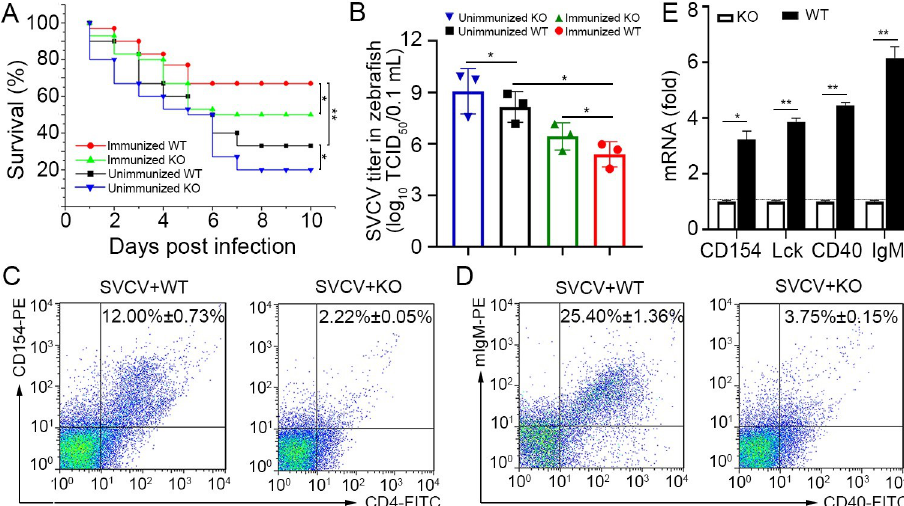
Fig 9. Verification of the functional role of Env38 in knockout zebrafish. (A) The functional role of Env38 was verified by the impairment of the antiviral activity of Env38 -/- zebrafish after vaccination with formaldehyde- inactivated SVCV vaccine or infection with live SVCV. In both wildtype and knockout zebrafish, the immunized groups were i.p. inoculated with vaccine derived from 0.4% formaldehyde-inactivated SVCV (10 6 TCID 50 ) and then challenged with SVCV (10 5 TCID 50 ); whereas the unimmunized groups were challenged with SVCV (10 5 TCID 50 ) without vaccination. Data points were from three independent experiments, and 30 zebrafish were used in each experiment (n = 30). Differences were analyzed using log-rank test. (B) Viral titer (TCID 50 ) was measured to evaluate the viral load in the wild type and knockout zebrafish with or without vaccinated immunoprotection. Viral samples were prepared from zebrafish at 4th day post SVCV (10 5 TCID 50 ) infection. The TCID 50 was examined in EPC cells by using Reed-Muench method. Viral titers were log 10 transformed prior to statistical analysis. Data points were from three independent experiments, and three zebrafish were used for viral sample preparation in each experiment (n = 3). (C and D) The degree of CD4 + T and IgM + B cell activation between WT and KO zebrafish under SVCV (10 5 TCID 50 ) stimulation was represented by the percentage of CD4 + CD154 + T and IgM + CD40 + B cells with mouse anti-CD154 (1:500), rabbit anti-CD4 (1:500) (C) and mouse anti-mIgM (1:2,000), rabbit anti-CD40 (1:500) (D) through determination with FCM analysis. The data presented in each block diagram indicated the average percentage of CD4 + CD154 + T and IgM + CD40 + B cells in WT and KO zebrafish. (E) The degree of CD4 + T or IgM + B cell activation between WT and KO zebrafish under SVCV (10 5 TCID 50 ) stimulation was represented by the transcriptional levels of cd154 , lck , cd40 and IgM through RT-qPCR. The RT-qPCRs were run in combination with the endogenous β -actin control. Error bars represented SEM. ( � p < 0.05; �� p < 0.01; ��� p < 0.001; ns, no significant